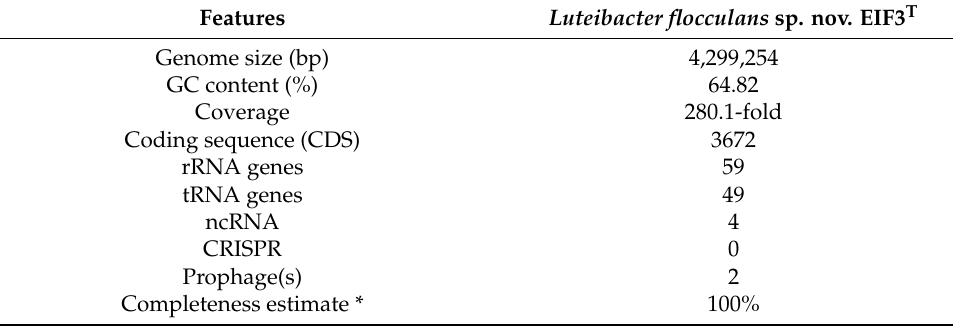
Table 3. Genome statistics of the Luteibacter flocculans sp. nov. EIF3 T chromosome.